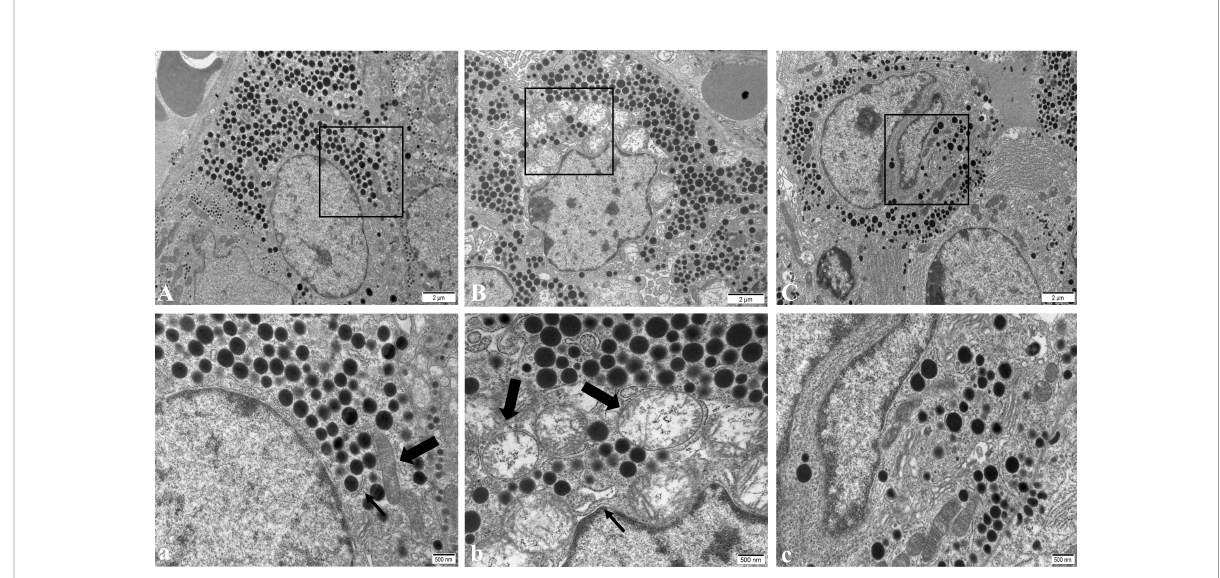
FIGURE 4 Ultrastructure of pituitary gonadotropin cells in male mice of NC group (A) , WD group (B) and DMSA group (C) . The black rectangle corresponds to the local magni fi cation of each group of gonadotropin cells (a – c) . In panel (a) , the coarse arrow shows mitochondria and the thick arrow shows the rough endoplasmic reticulum. In panel (b) , the coarse arrow indicates the swollen and degenerated mitochondria and the thick arrow indicates the enlarged rough endoplasmic